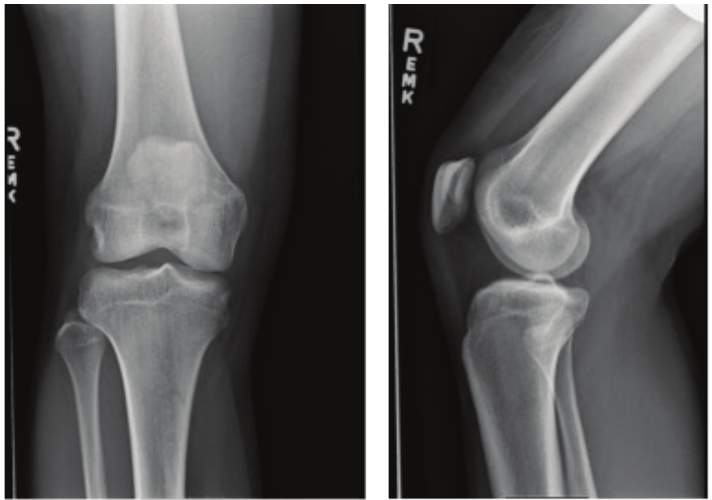
Figure 2: AP and lateral X-ray views of the right “unaffected”